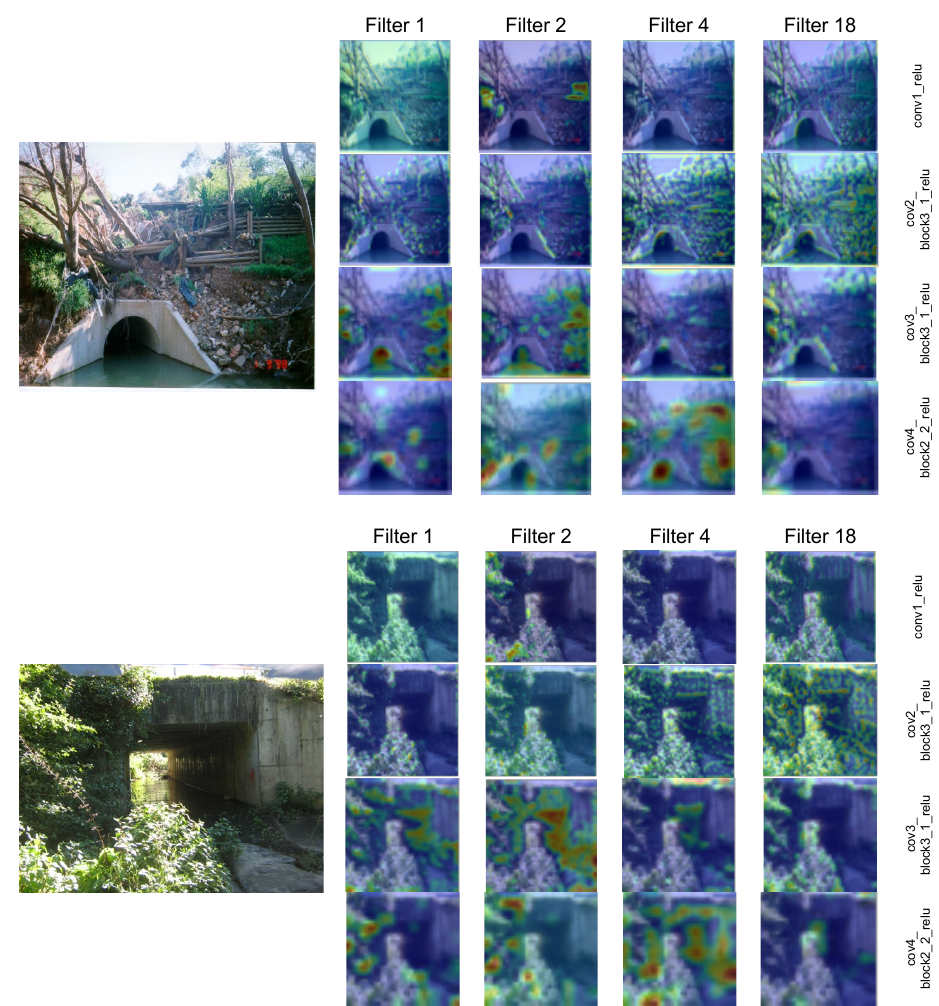
Figure 11. Selected ResNet50 CNN layers